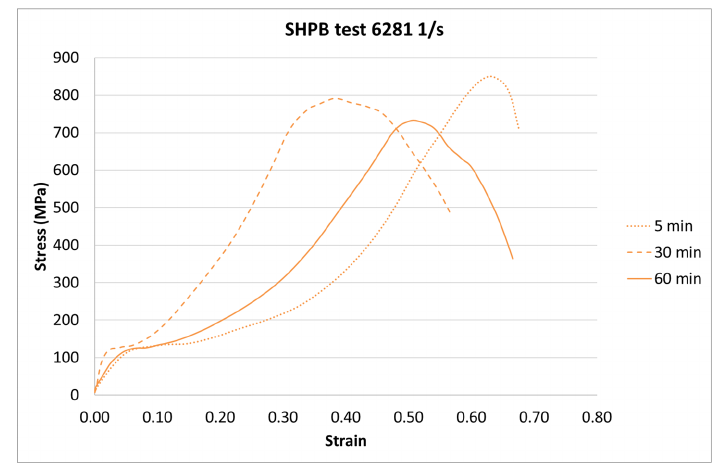
Figure 15. Results of the SHPB test (strain rate of 6281 1/s) of durable resin for curing times of 5, 30, and 60 min for UV and heat exposure.